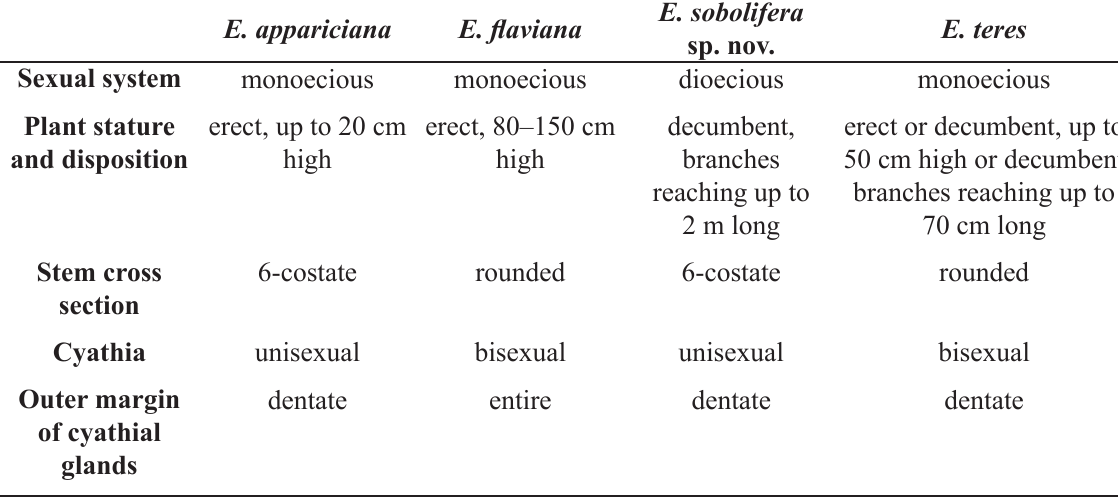
Table 3. Morphological comparison among E. appariciana Rizzini, E. flaviana Carn.-Torres &